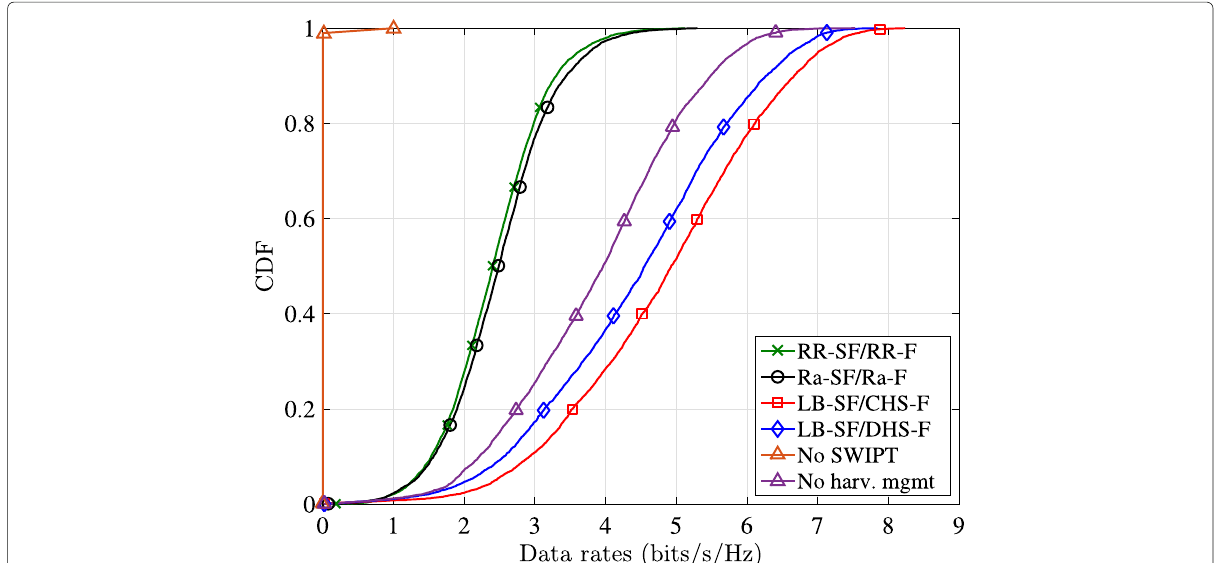
Fig. 6 CDF of the individual data rates. CDF of the individual data rates of all the users in the system for the different